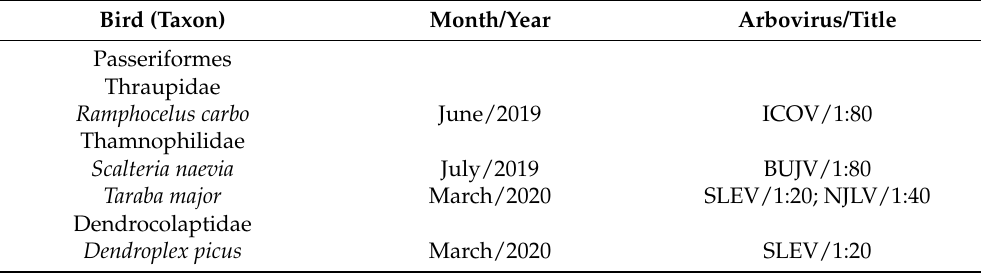
Table 3. Free-ranging birds captured at APA-Belem (Par á , Brazil) were positive for the presence of arbovirus antibodies in the HI test.